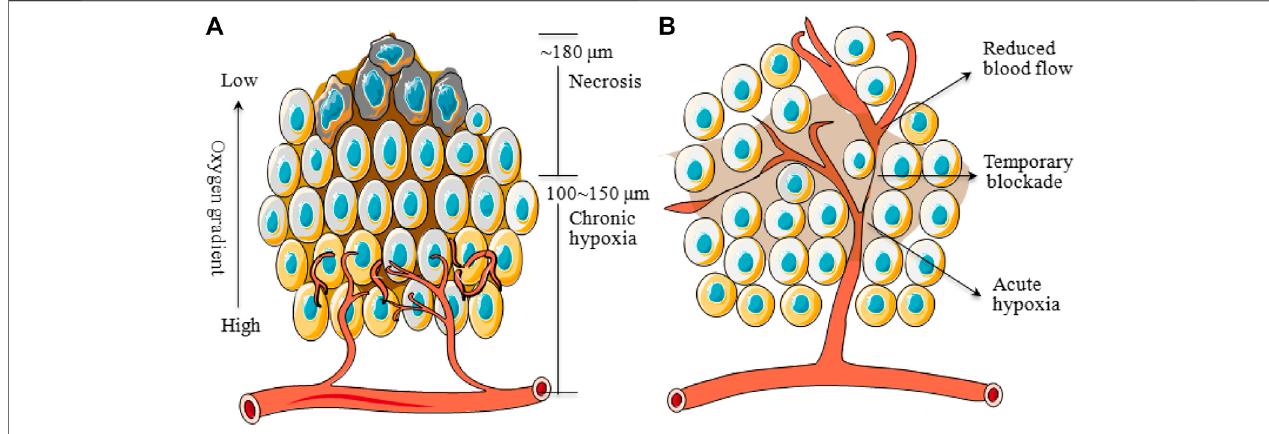
FIGURE1| Schematicdiagramofchronicandacutehypoxiaoftumors. (A) :Regionsofchronichypoxiaandnecrosisareusually100 ∼ 150and ∼ 180 μ mawayfrom blood vessels. (B) : Areas of acute hypoxia can develop as a result of the temporary blockade or reduced fl ow in certain vessels.